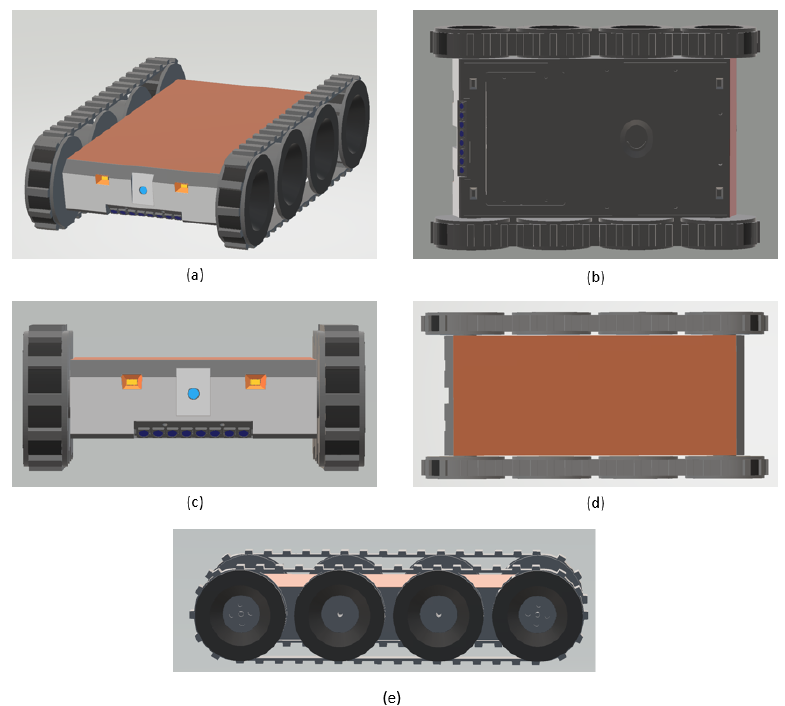
Figure 2. Design of the robot. ( a ) Isometric view; ( b ) bottom view; ( c ) front view; ( d ) top view;